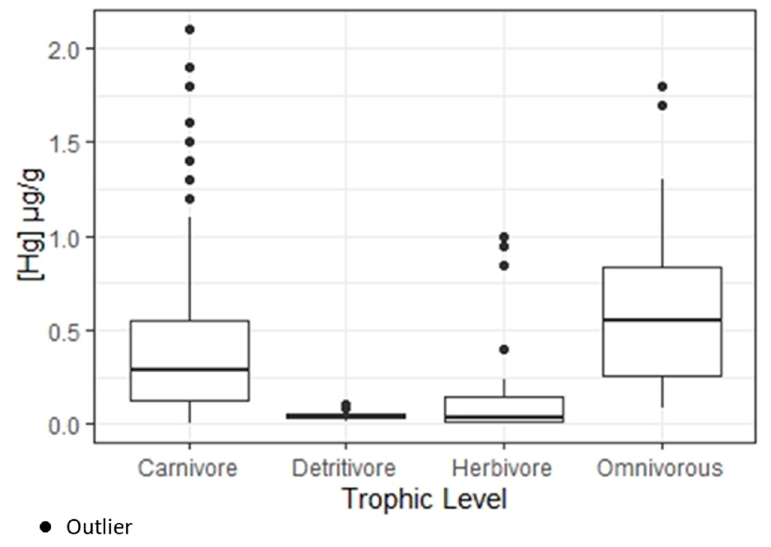
Figure 2. Distribution of mercury concentrations in fish (µg/g) by trophic level.